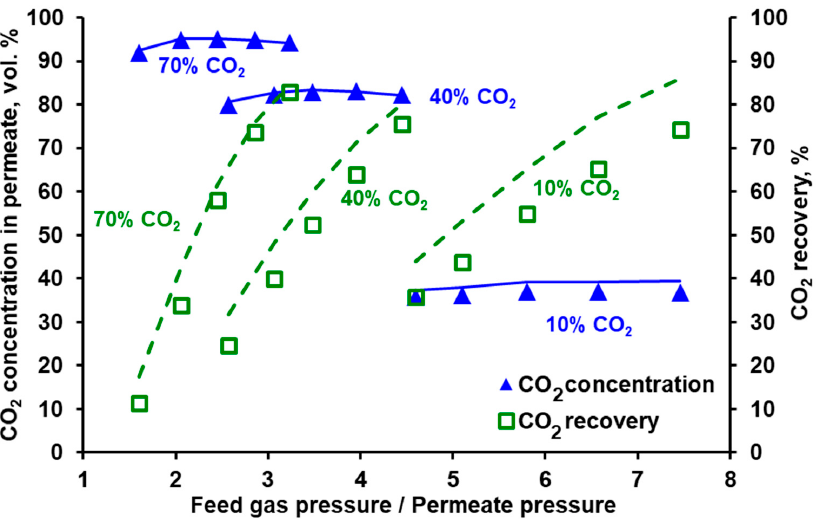
Figure 5. Experimental (points) and theoretical (lines) CO 2 purity and recovery in Air Products PRISM PA1020 module against feed to permeate pressure ratio for various carbon dioxide content in the feed CO 2 /N 2 mixture. Feed gas flow rate: 0.05 kmol h − 1 , temperature: 293 K. Standard deviation; purity = ± 0.4, recovery = ± 0.1.